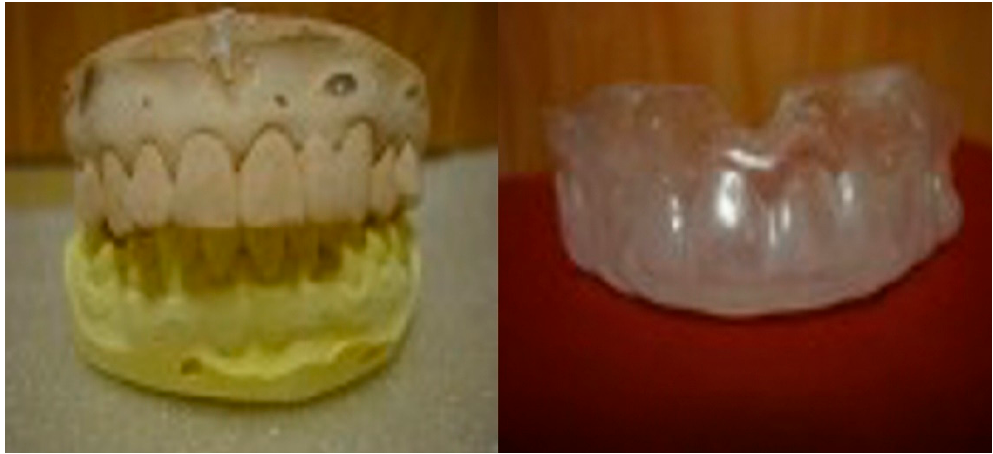
Figure 1. An example of a customized mouthguard .